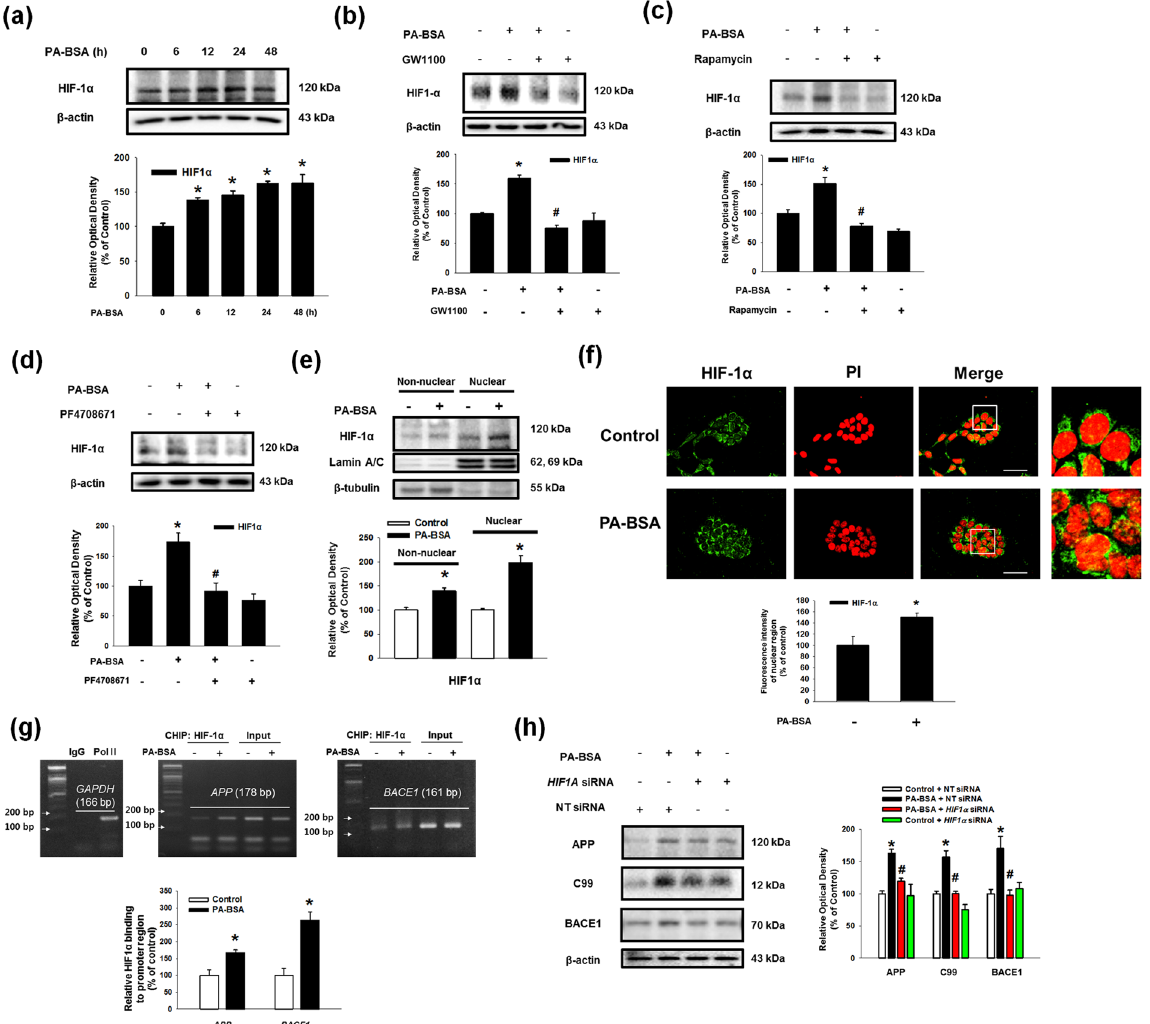
Figure 6. Role of mTOR/HIF-1 α pathway activated by PA-BSA in APP and BACE1 expressions. ( a ) SK-N-MC cells were incubated with PA-BSA (50 μ M) for 0–48 h. The expressions of HIF-1 α and β -actin were detected by western blot. Data are presented as a mean ± S.E.M. n = 4 . ( b – d ) SK-N-MC cells were pre-treated with GW1100 (10 μ M), Rapamycin (10 nM) and PF4708671 (10 μ M) for 30 min prior to incubation with PA-BSA (50 μ M). The expressions of HIF-1 α and β -actin were analyzed by western blot. Data are reported as a mean ± S.E.M. n = 4 . ( e ) SK-N-MC cells were incubated with PA-BSA (50 μ M) for 24 h. HIF-1 α , Lamin A/C and β -tubulin in the non-nuclear and nuclear fractions were detected by western blot, respectively. The expressions of non- nuclear and nuclear protein were normalized by β -tubulin and Lamin A/C respectively. ( f ) SK-N-MC cells were immunostained with HIF-1 α antibody and PI. Scale bars, 50 μ m (magnification, × 600). Fluorescence intensity data of HIF-1 α in the nuclear region was reported as a mean ± S.E.M. n = 5 . ( g ) DNA was immunoprecipitated with IgG, RNA polymerase II and HIF-1 α antibodies. All samples including immunoprecipitation and input were amplified with the primers of GAPDH , APP and BACE1 promoters. Quantitative data for HIF-1 α binding to APP and BACE1 promoters were analyzed by real time PCR. Data are presented as a mean ± S.E.M. n = 4 . ( h ) HIF1A and NT siRNAs were transfected to SK-N-MC cells for 12 h prior to incubation with PA-BSA for 24 h. The expressions of APP, C99, BACE1 and β -actin were detected by western blot. Data are reported as a mean ± S.E.M. n = 4 . Each blot image is representative. * p < 0.05 versus control, # p < 0.05 versus PA-BSA